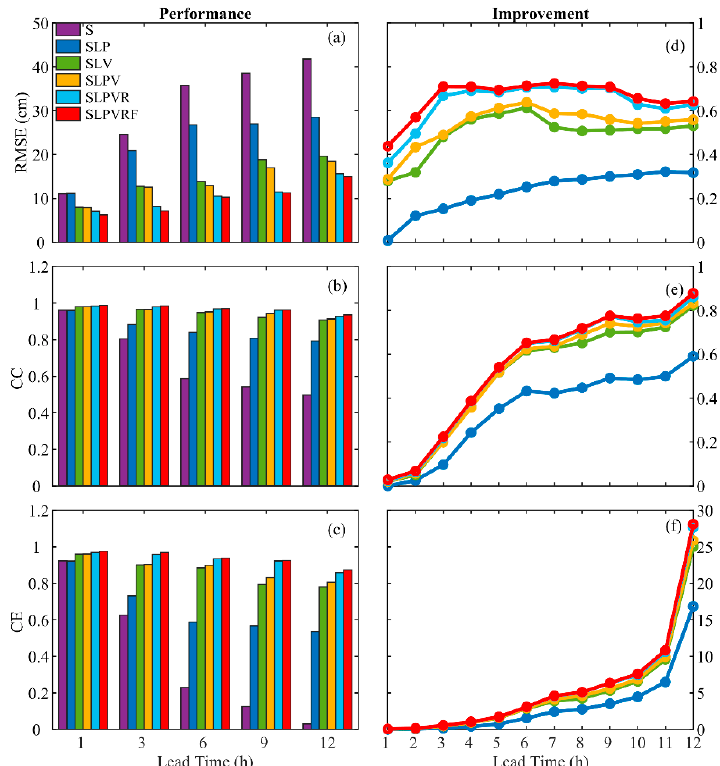
Figure 9. Prediction capability and performance improvement in terms of ( a , d ) root mean square error ( RMSE ); ( b , e ) correlation coe ffi cient ( CC ); and ( c , f ) coe ffi cient e ffi ciency ( CE) for all the training events.